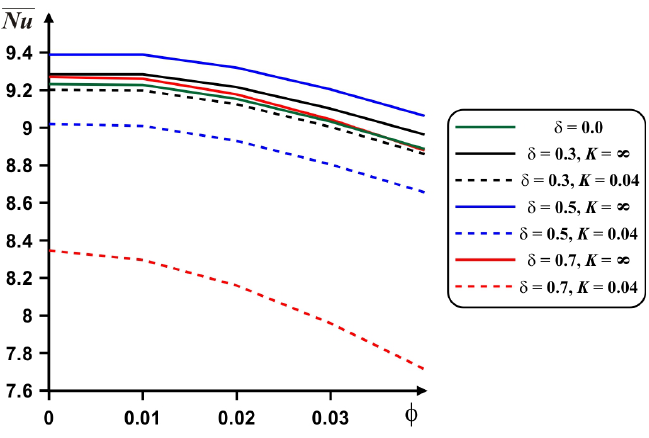
Figure 14. Dependences of the mean Nu on φ , δ and K for Ra = 10 6 .